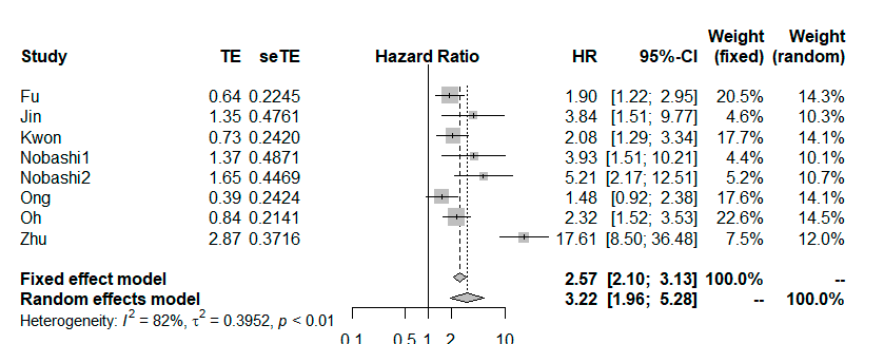
Figure 6. Forest plots of HRs of MTV for overall survival and progression-free survival. Nobashi1 refers to the results of the central type of SCLC. Nobashi2 refers to the results of the peripheral type of SCLC.